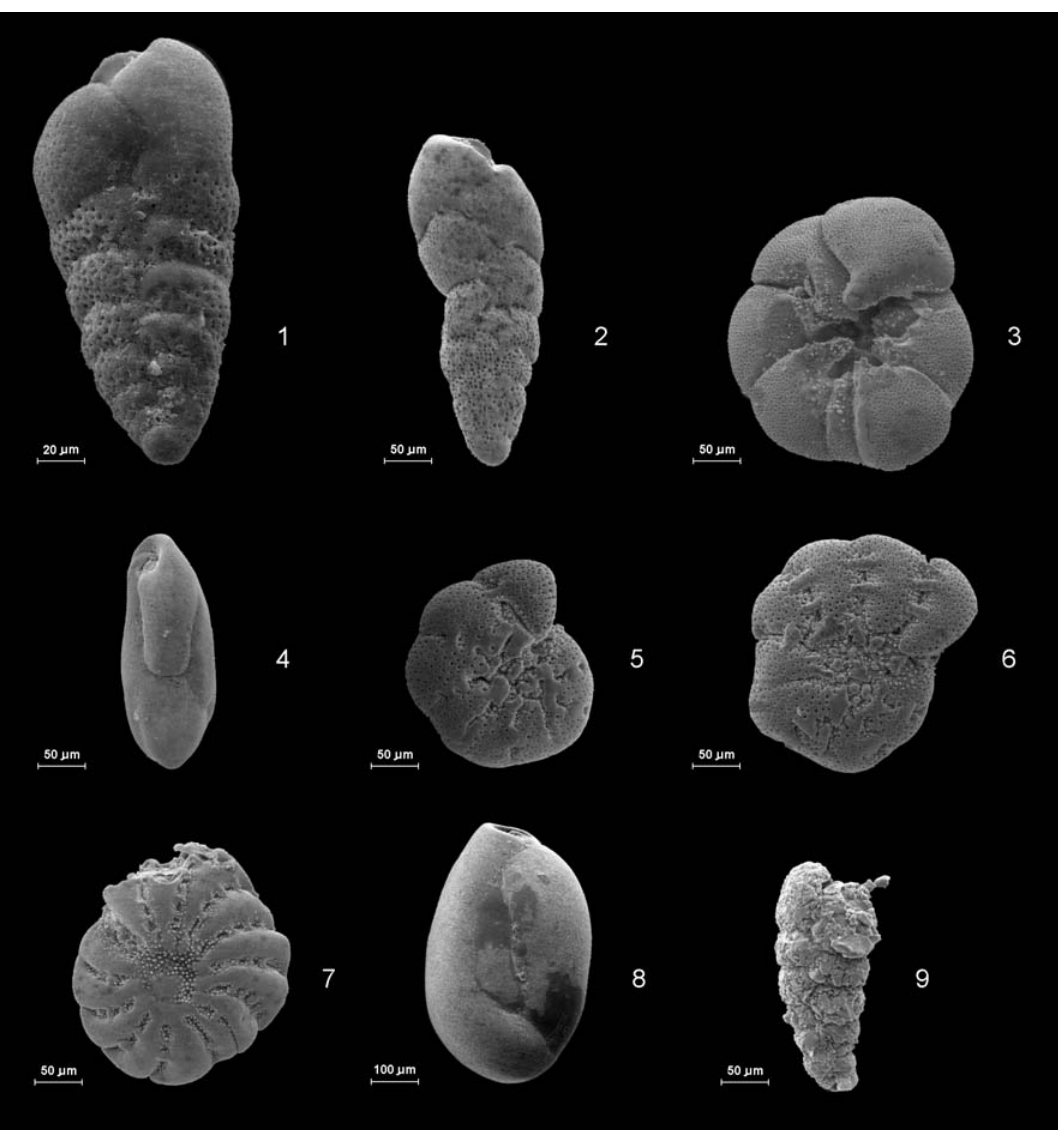
Fig. 4 – SEM photomicrographs of specimens from Niterói, Guanabara Bay: (1) Bolivina lowmani – Sample 15, collected in June 2000; (2) B. lowmani , deformed – Sample 14, collected in June 2000; (3) Ammonia tepida (Cushman) – Sample 40, collected in November 1999; (4) Buliminella elegantíssima (Orbigny) – Sample 15, collected in June 2000; (5) Elphidium gunteri Cole – Sample 14, collected in June 2000; (6) E. gunteri , deformed – Sample 14, collected in June 2000; (7) E. discoidale (Orbigny), deformed and broken – Sample 15, collected in June 2000; (8) Quinqueloculina seminulum (Linné) – Sample 14, collected in June 2000; (9) Textularia earlandi (Parker), broken – Sample 60, collected in November 1999.